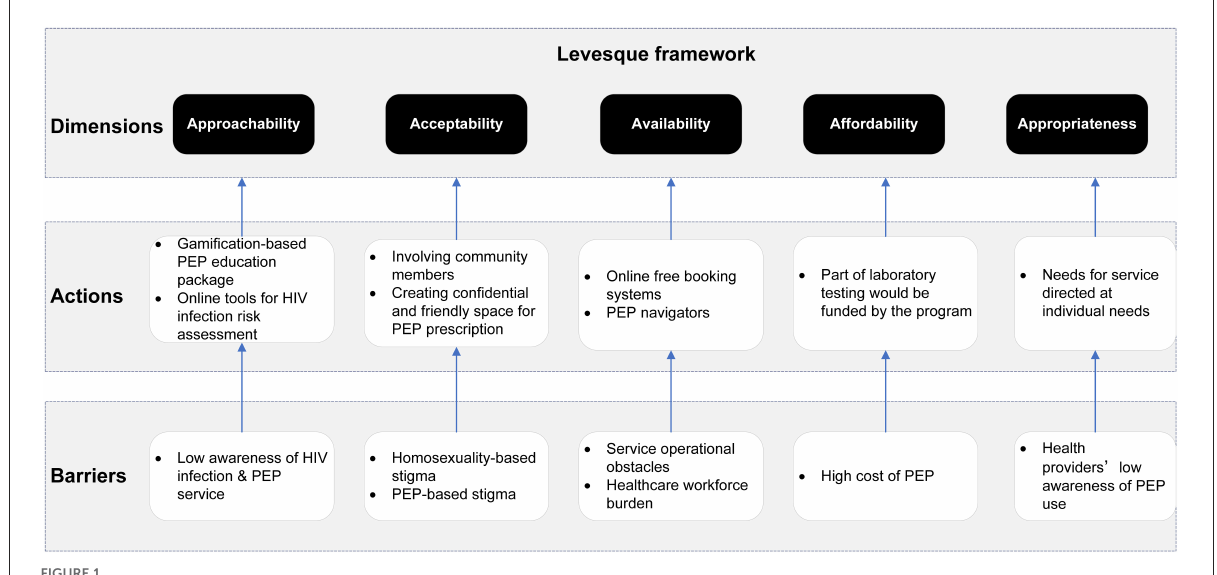
FIGURE1 The conceptual framework for the postexposure prophylaxis (PEP) uptake intervention. The conceptual framework in our study is informed by the Levesque framework, including five domains of accessibility of health services: approachability, acceptability, availability, affordability, and appropriateness.